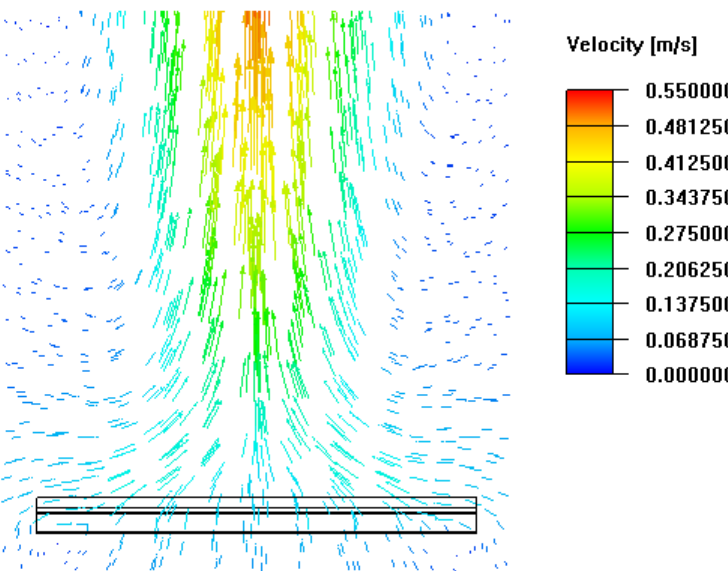
Figure 14. Velocity vectors plotted at the array center along the mid-section of the fin channel transverse to the openings of the LED grow light, illustrating the vertical flow of air through the openings and converging into a plume ( H = 40 mm, s = 12.85 mm, and Q e = 240